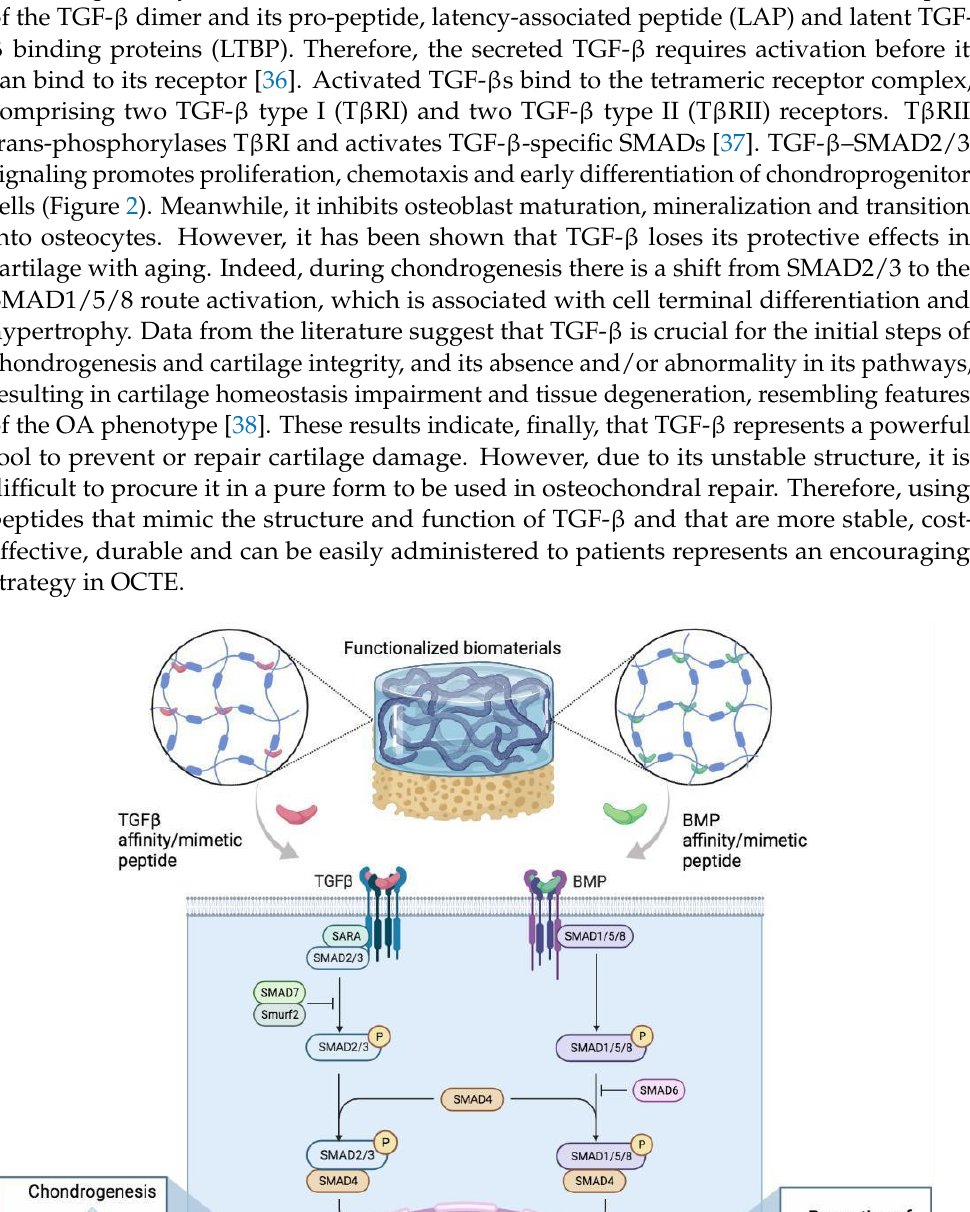
Figure 1. Schematic representation of peptides used in OCTE as a powerful tool to mimic the native osteochondral tissue.